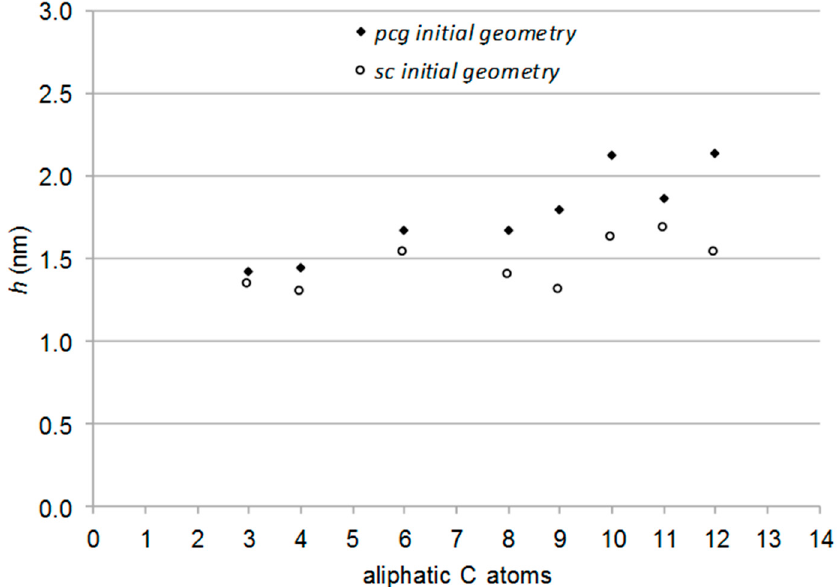
Figure 9. AATEABs maximum length versus carbons number of the surfactant’s aliphatic chain using the QM/MM optimized structures.